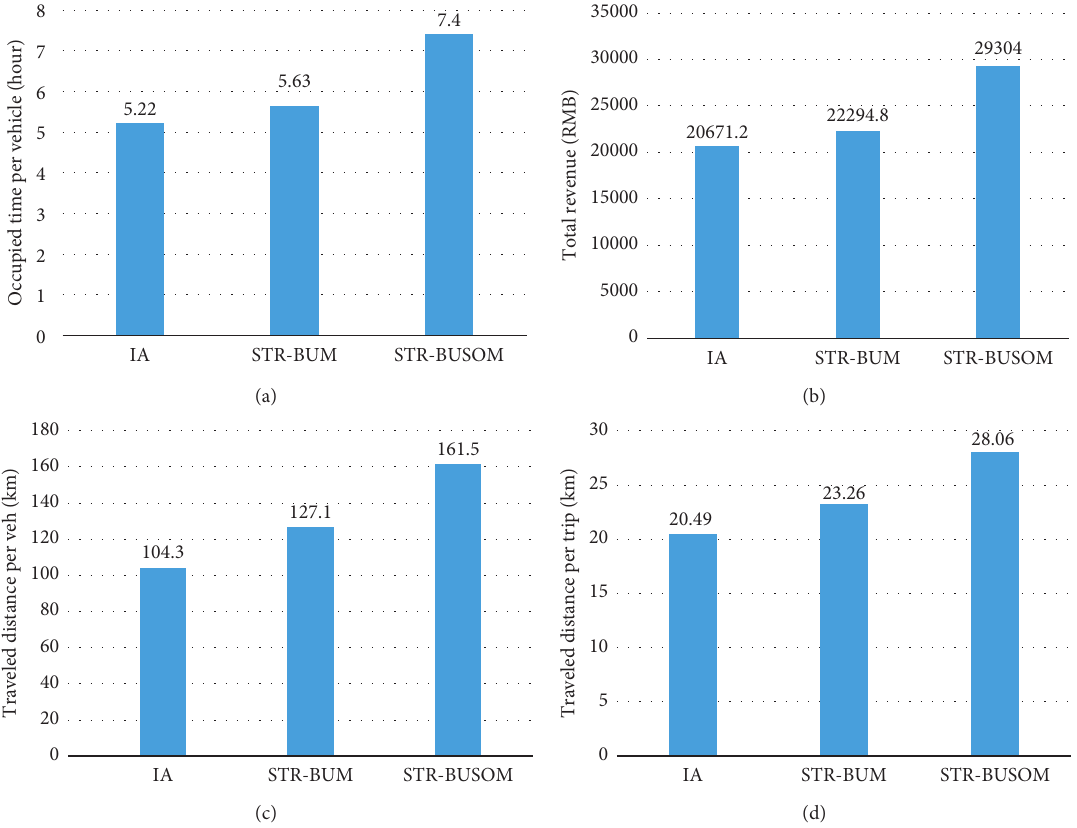
Figure 9: Comparisons on operation indicators. (a) Average occupied time per vehicle. (b) Total revenue. (c) Average traveled distance per vehicle. (d) Average traveled distance per